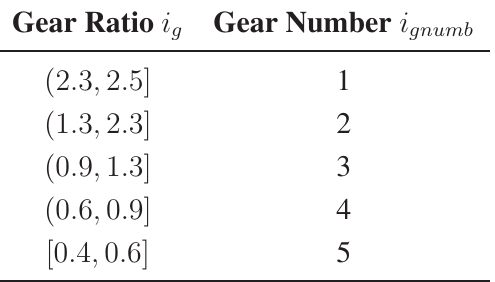
Table 1. Converting table from the gear ratio to the gear